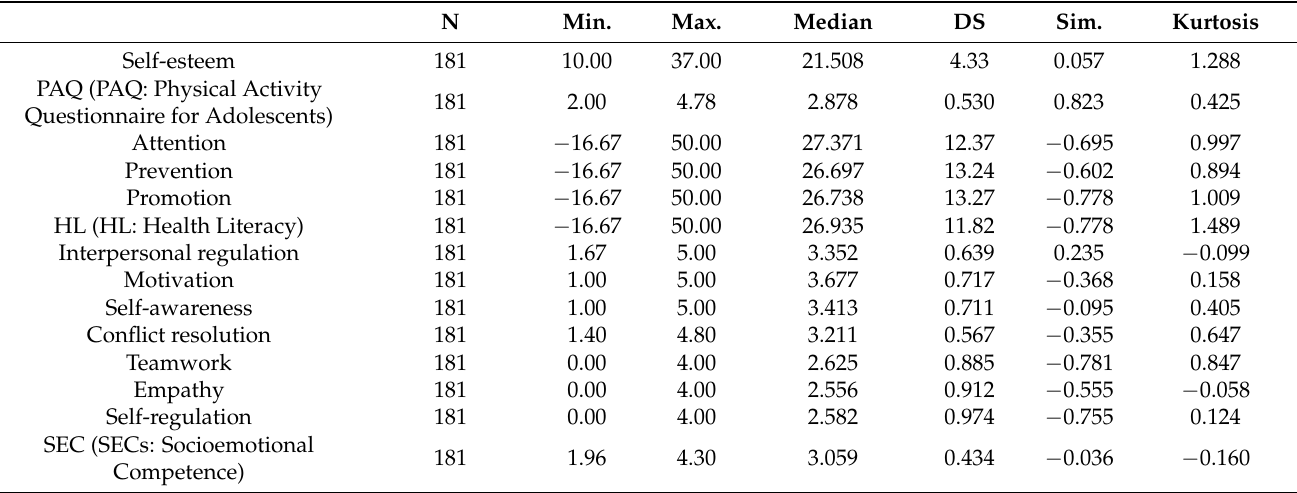
Table 2. Physical activity level, health literacy, socioemotional competencies, and self-esteem in at-risk youths in Guatemala. N Min. Max. Median DS Sim. Kurtosis